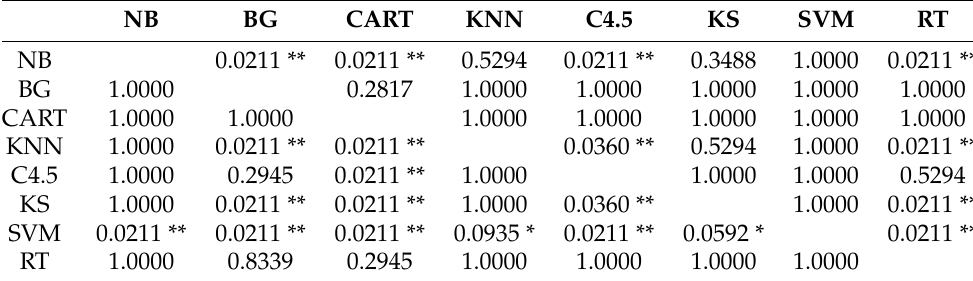
Table 19. Pairwise WSR test for F1-Measure of